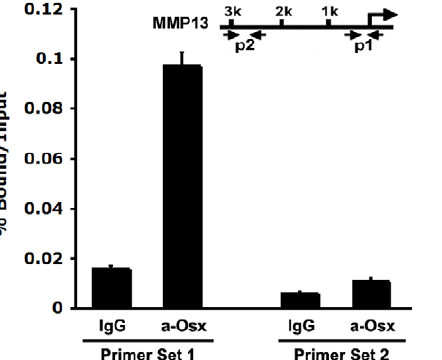
Figure 6. Endogenous Osx in primary osteoblasts is associated with the native MMP13 promoter in vivo. Chromatin Immunopre- cipitation (ChIP) assays were conducted using primary calvarial osteoblasts isolated from new born wild-type mice. Anti-Osx antibody (a-Osx) was used for ChIP analysis, and IgG was used as a negative control. The precipitated chromatin was analyzed by quantitative real- time PCR. As described in the Methods, primer Set 1 corresponds to a segment covering the GC-rich element within 80 bp MMP13 promoter. As a negative control, Primer Set 2 covers a distal 3 kb region of the MMP13 promoter, which does not contain GC-rich sequences.